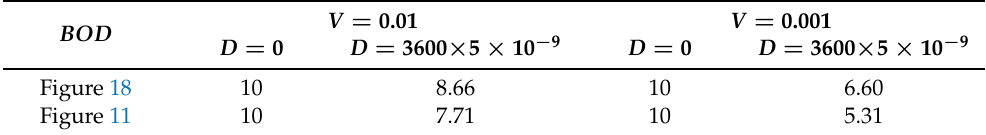
Table 7. BOD values at initial moments of time for different